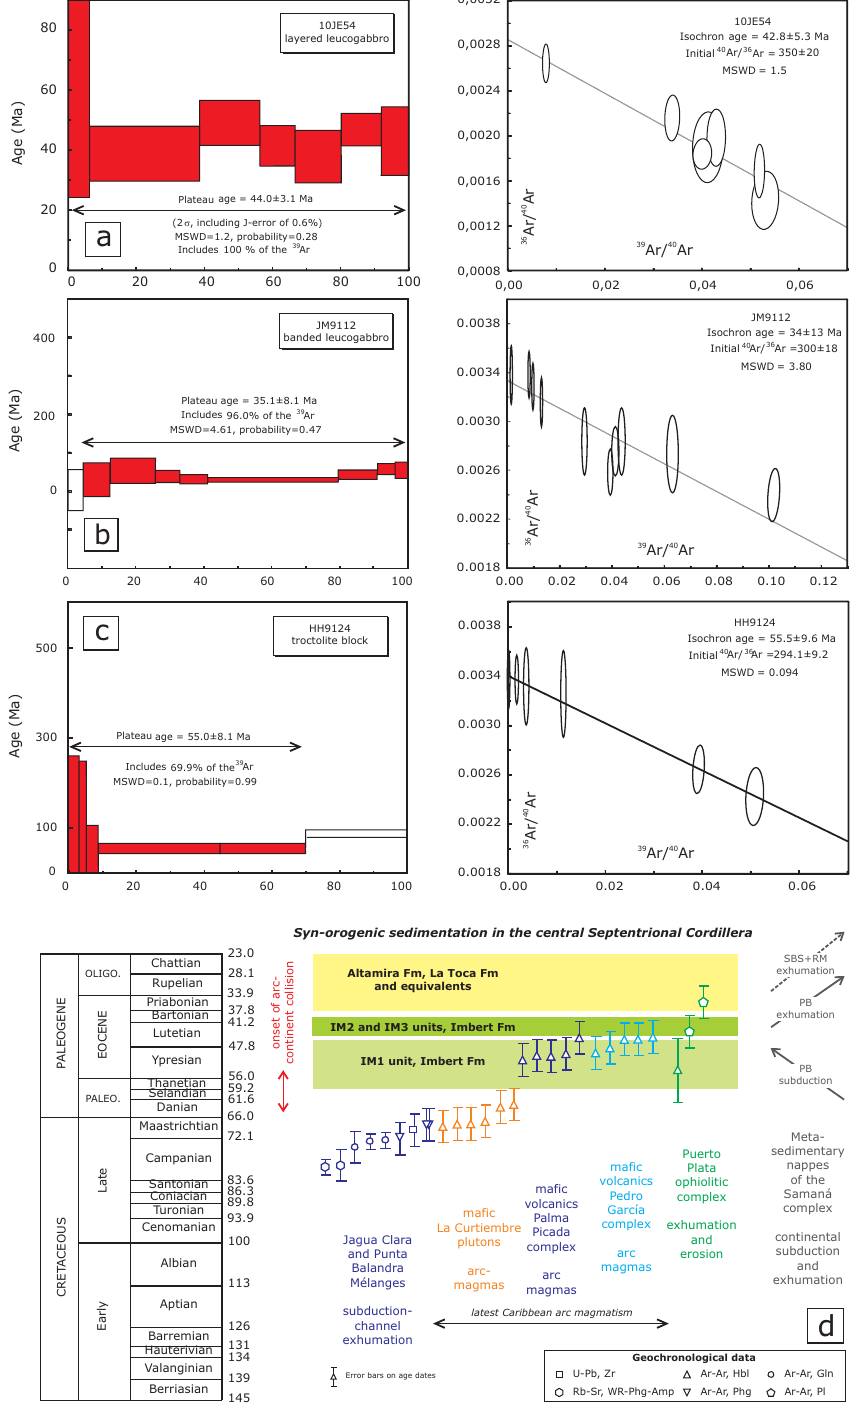
Figure 10. (a, b, c) 40 Ar / 39 Ar spectrum and isochron diagrams of plagioclase from leucogabbros of the Puerto Plata ophiolitic complex and of hornblende from a troctolite block in the Imbert Fm. Analytical procedures are described in Escuder-Viruete et al. (2014). A summary of 40 Ar– 39 Ar incremental heating experiments is in Supplementary Material D. Age uncertainties are 2 σ and include uncertainty in monitor age and decay constant. (d) Temporal relationships between the exhumation of the Jagua Claramélange (end of oceanic subduction), the latest Caribbean arc magmatism, the exhumation of the SSZ ophiolite, and the sedimentation of the Imbert Fm in the central Septentrional Cordillera, as well as the subduction and exhumation of the Samaná nappes (continental subduction). See text for discussion.